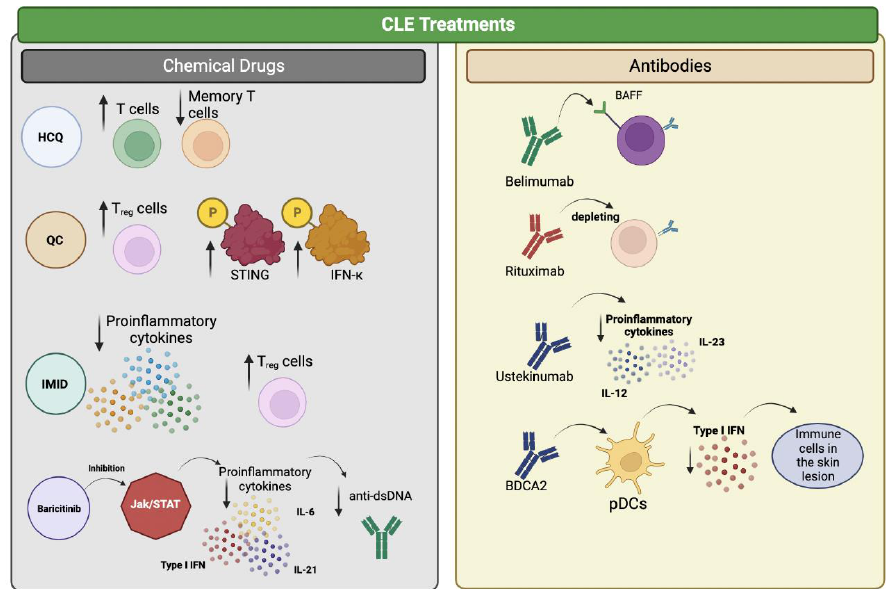
Figure 2. Treatments against CLE. The figure shows different treatments evaluated in humans and their interaction with the immune system. Treatments based on chemical compounds are shown in the left panel. Monoclonal antibodies evaluated as therapy against CLE are shown in the right panel. The arrows pointing up symbolize an increase, while the arrow pointing down represents a